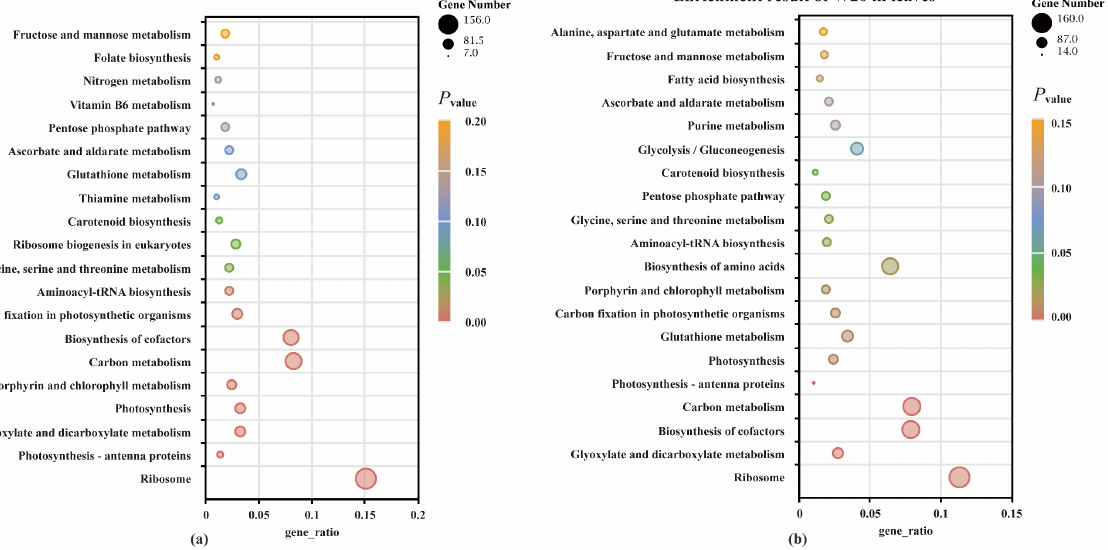
Figure 5. The statistics of KEGG enrichment in leaves and roots of barley. ( a , b ) show the KEGG enrichment results of the differentially expressed genes (DEGs) in W26 and W20 leaves, respec ‐ tively. ( c , d ) show the KEGG enrichment results of the DEGs in W26 and W20 roots, respectively. The abscissa in the figure is the ratio of the number of DEGs annotated on the KEGG pathway to the total number of DEGs, and the ordinate is the KEGG pathway name. The depth of color repre ‐ sents the degree of enrichment. As for the common pathways of roots KEGG enrichment ( p adj ≤ 0.05) were four path ‐ ways shared by the two genotypes (Figure 5c,d), namely, “Photosynthesis ‐ antenna